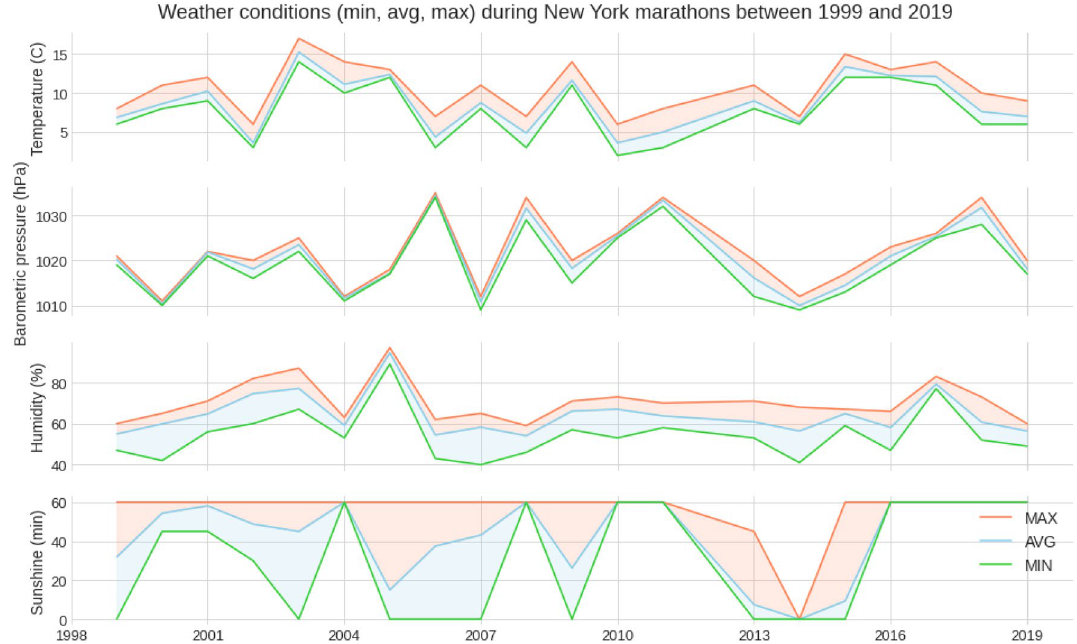
Figure 1. Weather conditions in the ‘New York City Marathon’ between 1999 and 2019.